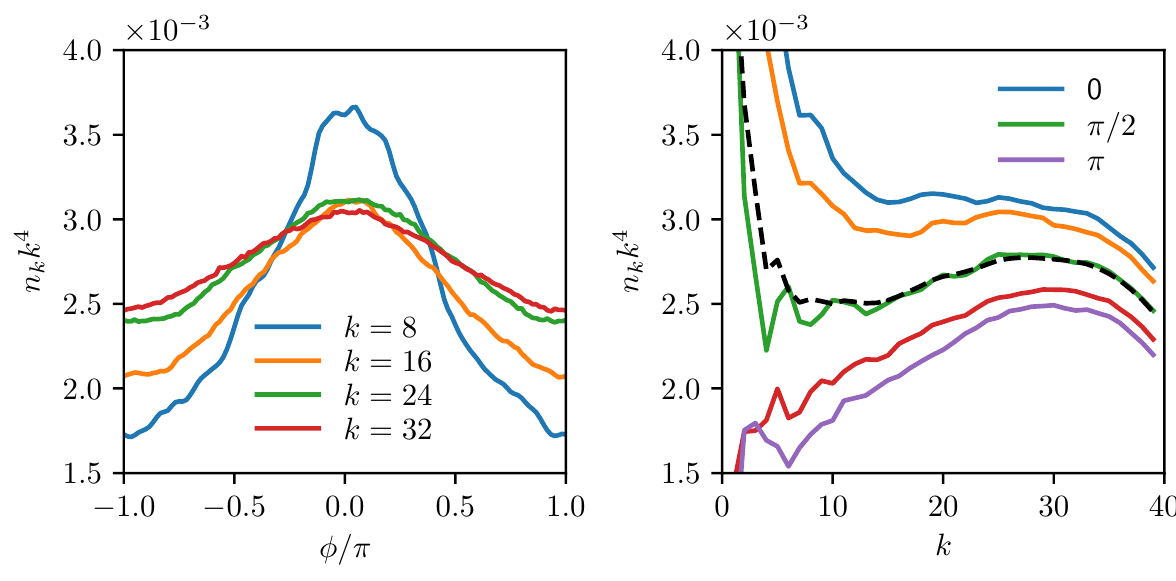
Figure 4. Angular ( left ) and radial ( right ) slices of the spectra averaged over a single long in the local frame along the instantaneous anisotropy vector. f =